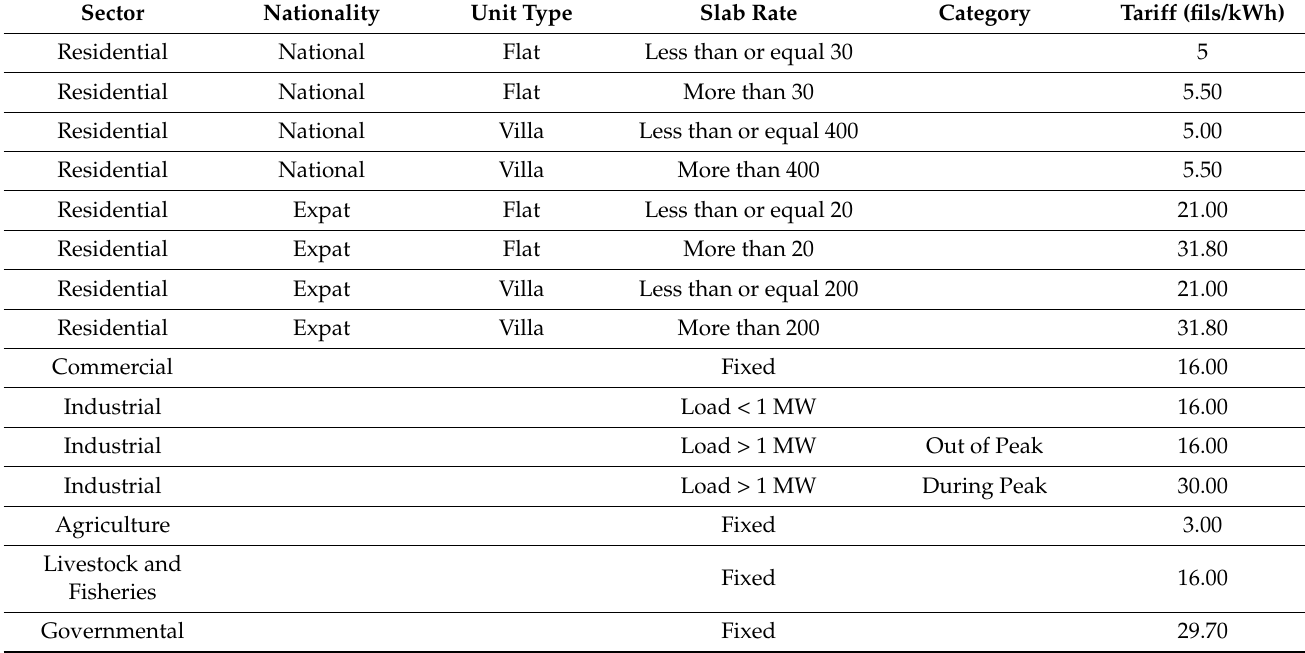
Table 1. DoE electricity tariff by slab rate sector in 2016 [85].